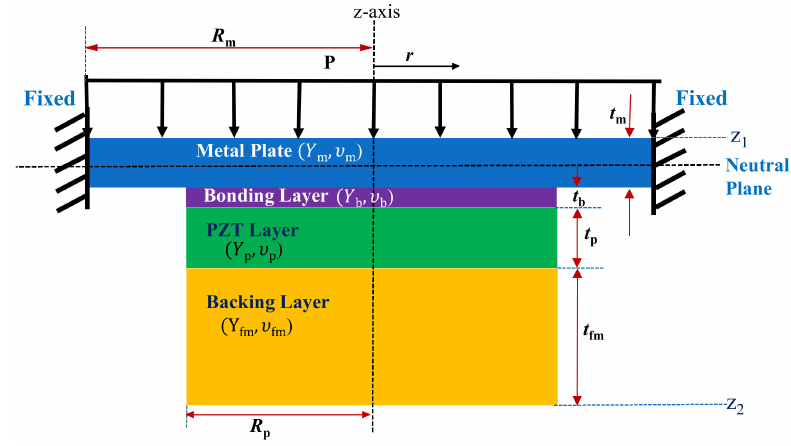
Figure 2. Schematic of the axisymmetric multilayered structure in the z-r